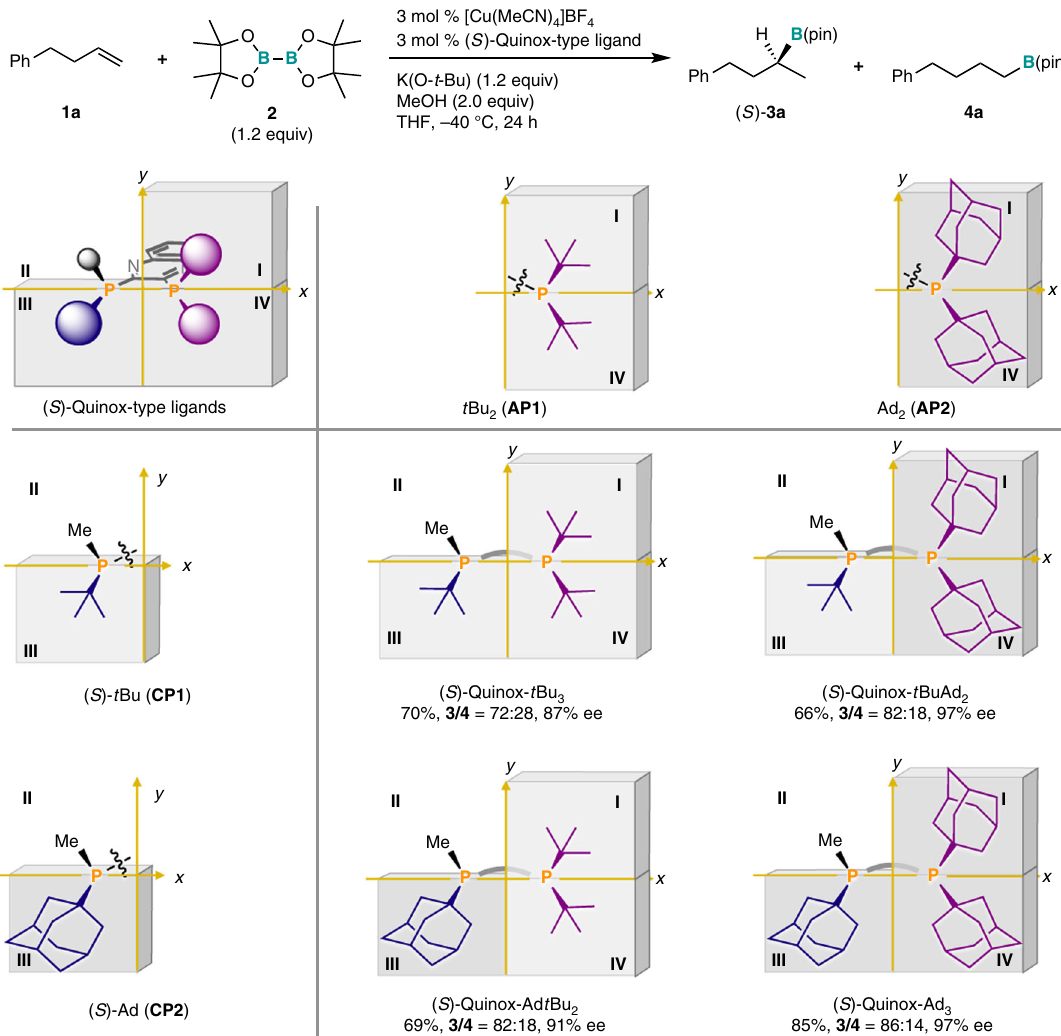
Fig. 4 The fi rst ligand synthesis step with the design guideline and the second ligand evaluation step. Yields (%) of 3a and regioselectivities ( 3 / 4 ) were determined by the gas chromatography (GC) analysis using the crude material. Enantioselectivities (% ee) were determined by the high-pressure liquid chromatography (HPLC) analysis with a chiral